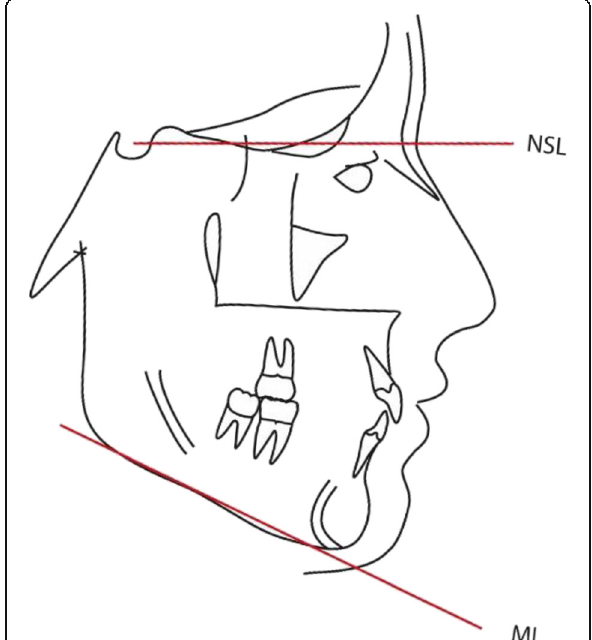
Fig. 1 Cephalometric analysis. Landmarks and reference lines used for angular measurements in the lateral cephalograms, NSL nasion-sella line, ML mandibular